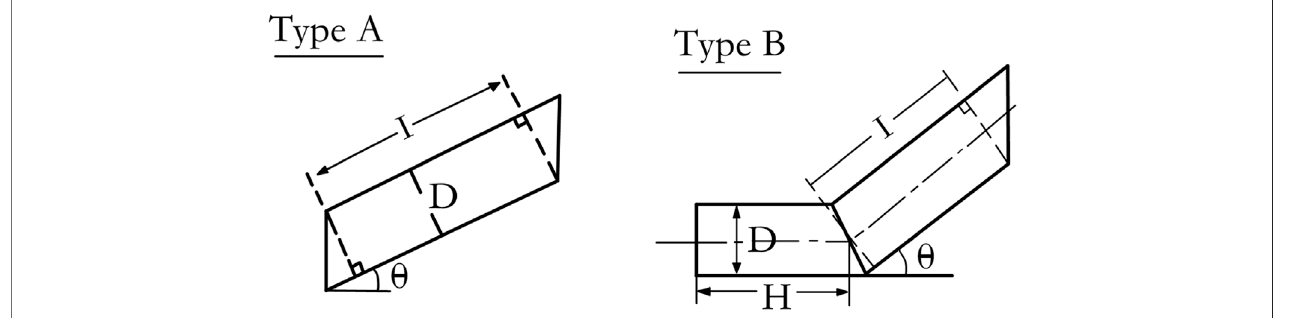
FIGURE 3 | Schematic diagram of experimental Types A and